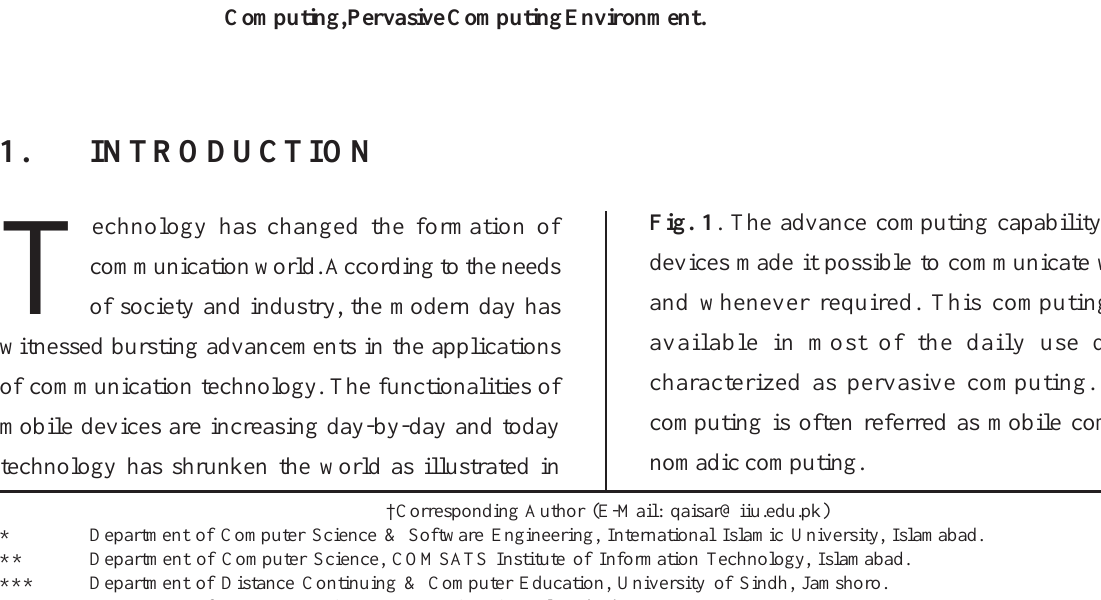
Fig. 1 . The advance computing capability of